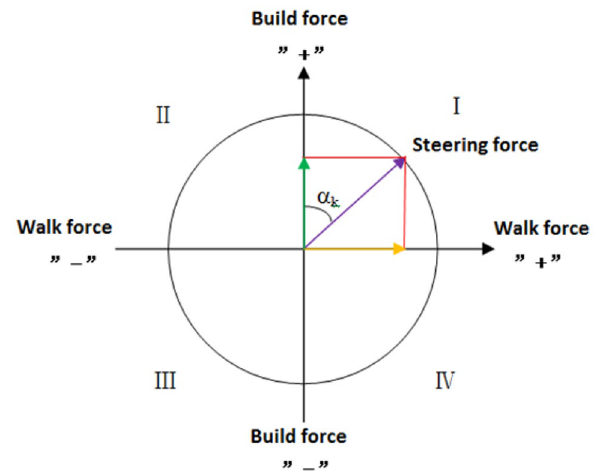
Fig. 5 steering force distribution in bottomhole plane